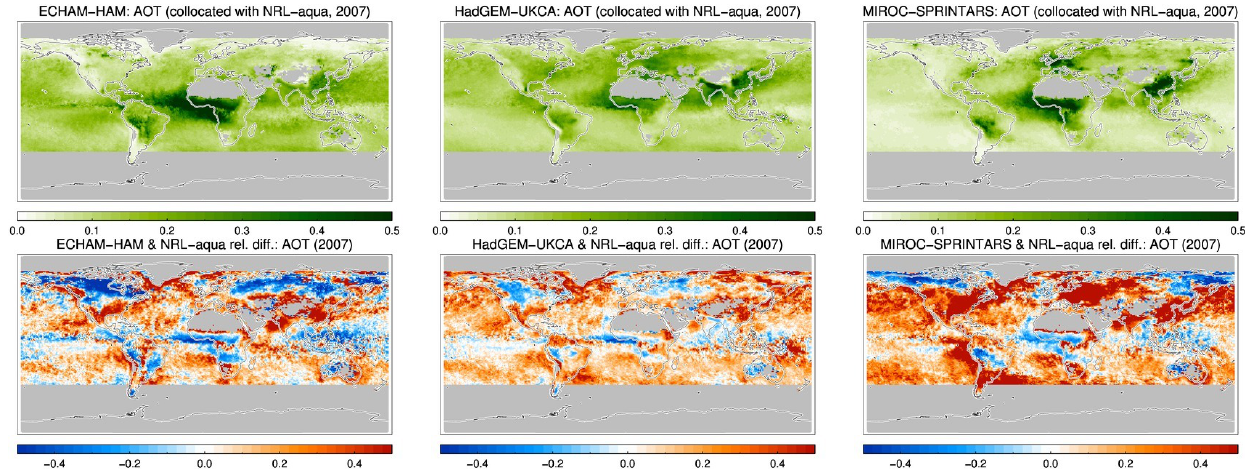
Figure 8. Top row shows global map of yearly mean of model AOT collocated with MODIS-NRL Aqua AOT data. Bottom row shows the relative temporal sampling error using MODIS-NRL Aqua AOT sampling. Grey colors indicate no observations available.